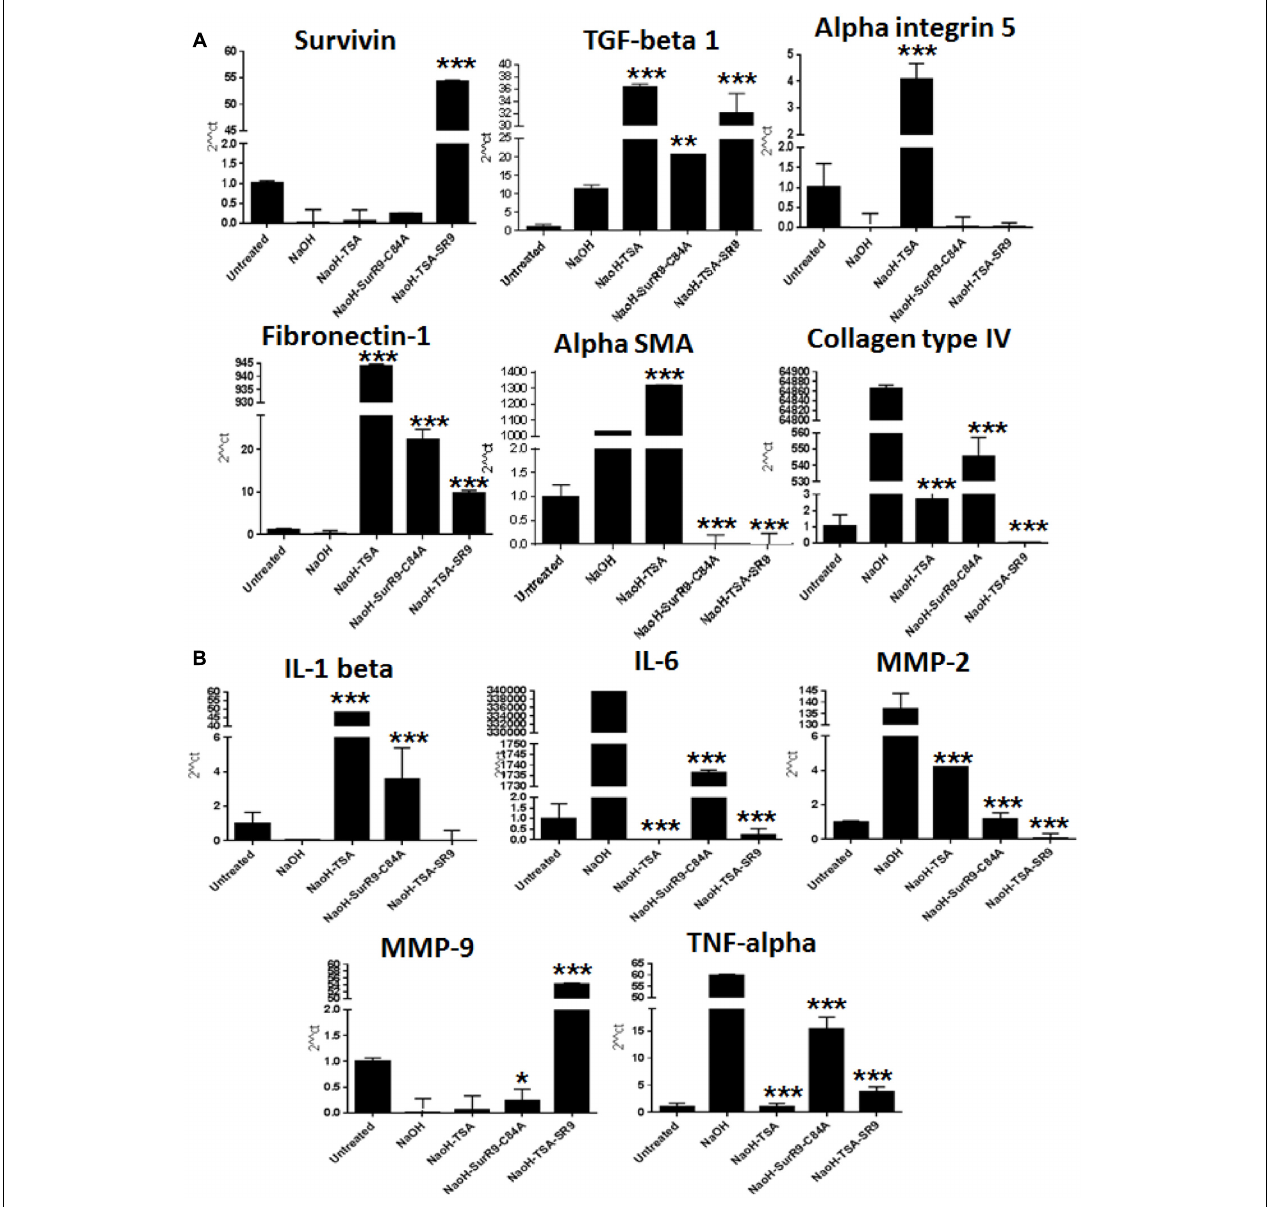
FIGURE 2 | Quantitative real-time PCR for expression of wound healing, tissue integrity and inflammatory markers: (A,B) The qRT-PCR analysis was carried out to determine the gene expressions of wound healing markers survivin, TGF-beta-1, tissue integrity markers alpha integrin 5, Fibronectin-1, alpha-SMA,